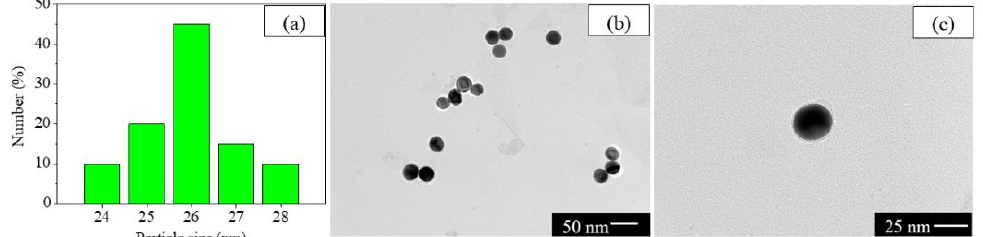
Figure 3. TEM images and a histogram image ( a ) of chitosan-coated Co 0.5 Zn 0.5 Fe 2 O 4 nanoparticles